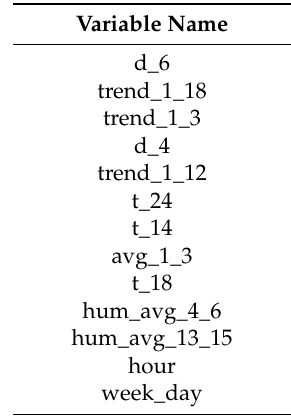
Table 4. Final set of independent variables for classification